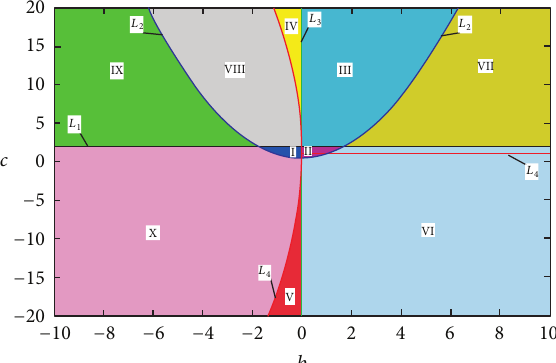
Figure 8: The stable region on the parameter plane (𝑏,𝑐) .